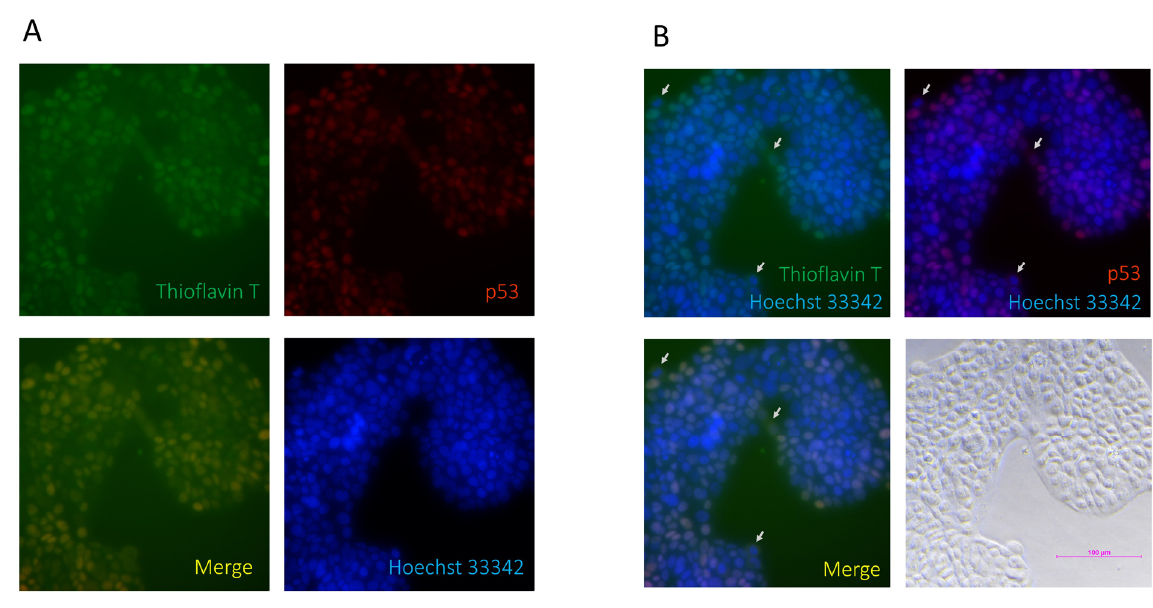
Figure 4. p53 is colocalized with thioflavin T in Detroit 562 cells. ( A ) p53 was used to stain for protein aggregation and is shown in red; thioflavin T was used to stain for protein aggregation and is shown in green; Hoechst 33342 was used to stain for nuclear counterstains and is shown in blue. p53 signals are shown to have the same location as the thioflavin T signals in the merged figure. ( B ) The merged figure shows that there are some cells with cytosolic thioflavin T/p53 signals